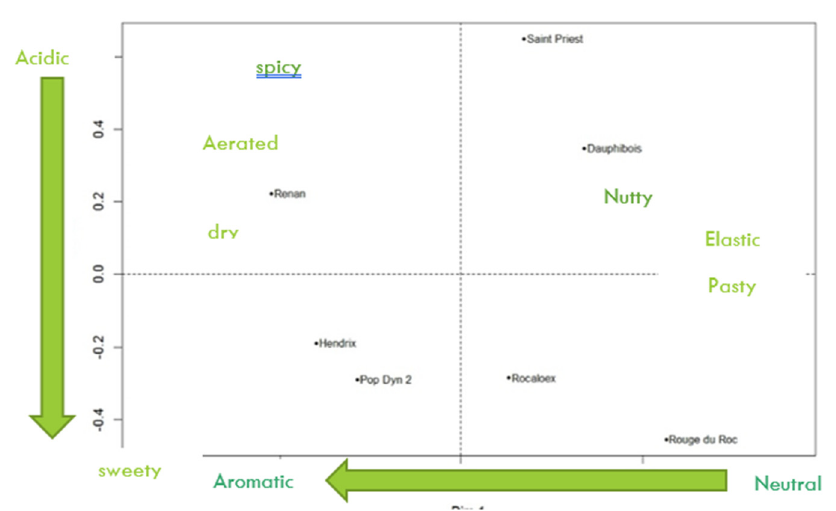
Figure A2. Common representation of 7 bread wheat populations perceived by 22 tasters: Results of MFA, dim 1 and 2: graph of the individuals.